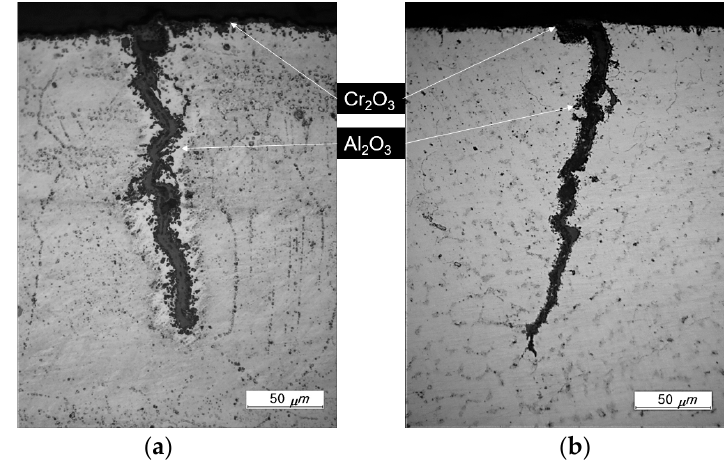
Figure 10. Surface cracking in creep-fatigue-tested specimens at 0.6% total strain range with 300 s holding time, showing breakdown of brittle-oxide cracking for: ( a ) Base metal; and ( b ) Weldments.